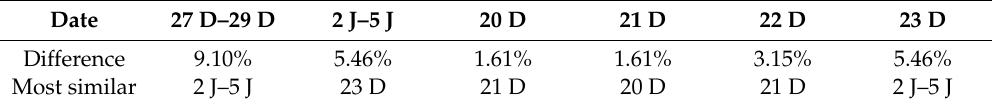
Table 11. Similarities and differences among Christmas periods profiles.